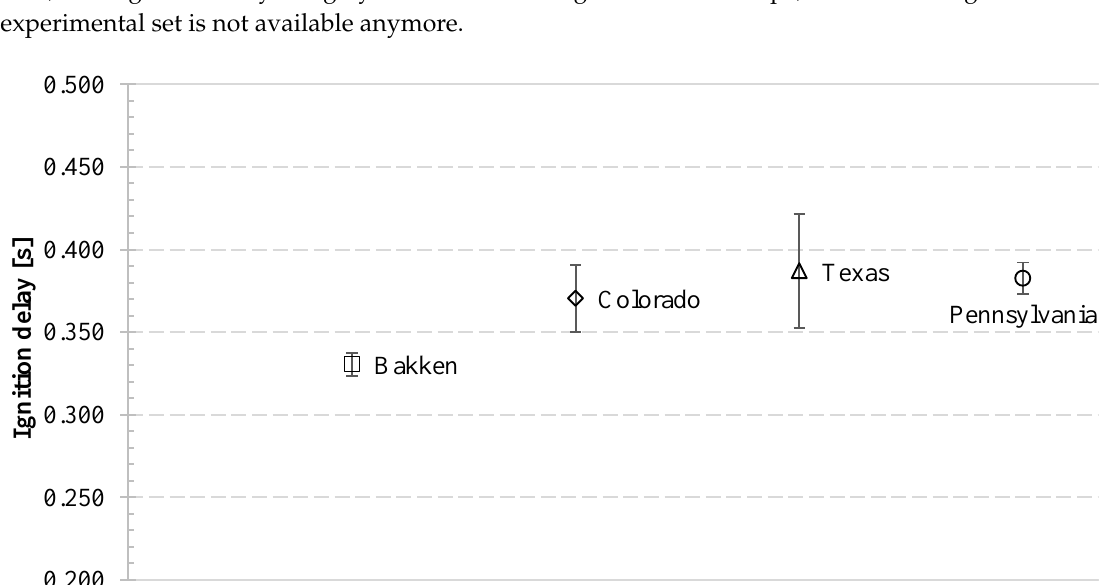
Figure 12. Average ignition delay for different crude oils.